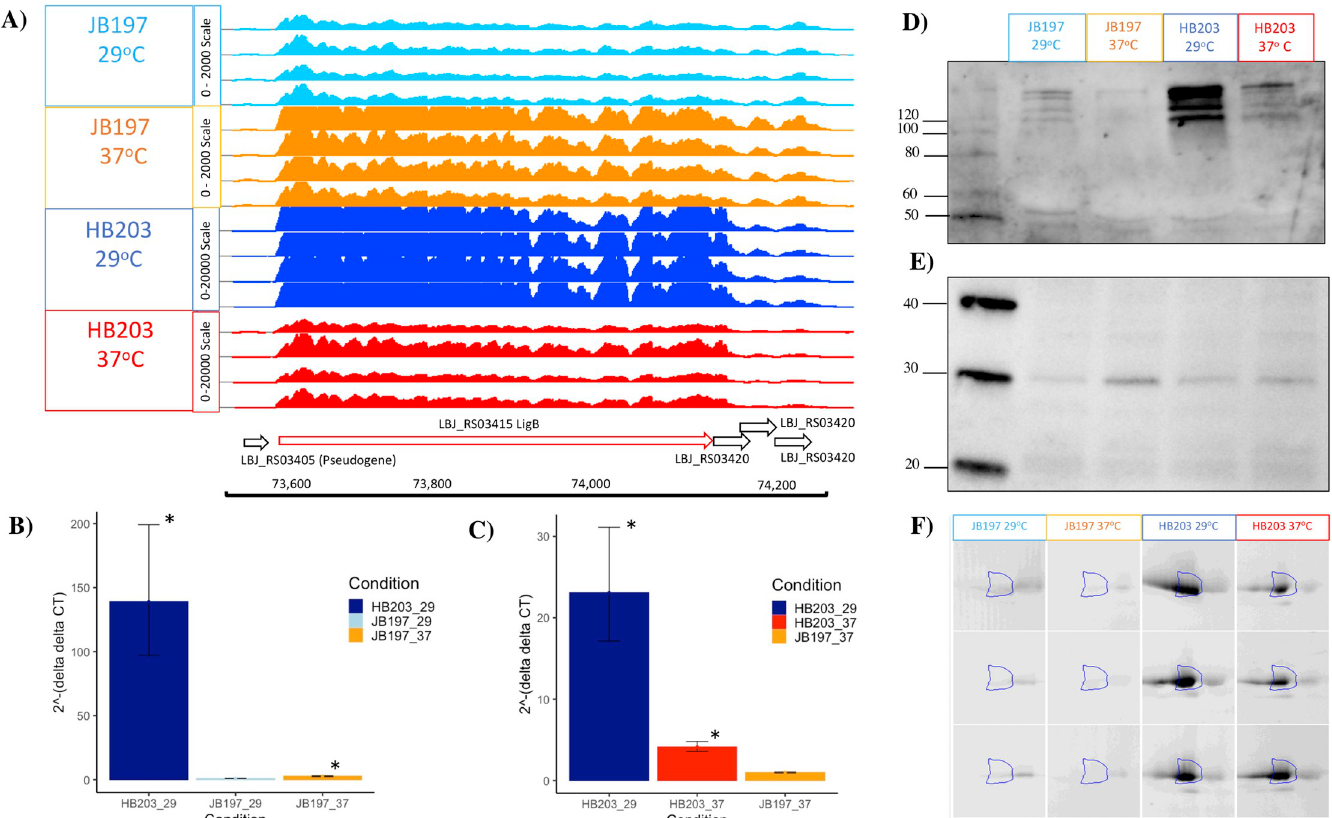
Fig 5. Evaluation of LigB expression in JB197 and HB203. (A) Integrated Genome Browser (IGB) view of gene expression (light blue = JB197 at 29˚C, orange = JB197 at 37˚C, dark blue = HB203 at 29˚C, red = HB203 at 37˚C). Note that Y-axis normalized read count scales are different; JB197 (both temperatures) was scaled to 0–2,000, while HB203 (both temperatures) was scaled 0–20,000. Validation of RNAseq data by RT-qPCR of ligB relative to JB197 at 29˚C, using secA as the control gene for the 29˚C (JB197 vs. HB203) and JB197 (37˚C vs. 29˚C) contrasts (B) or rho as the control gene for the 37˚C (JB197 vs. HB203) and HB203 (37˚C vs. 29˚C) contrasts normalized to the expression of JB197 37˚C (C). Each lane of the immunoblot contains approximately 5 x 10 8 leptospires of L . borgpetersenii serovar Hardjo strain JB197 and HB203 cultured at 29 or 37˚C with (D) anti-LigB and (E) anti-LipL45. (F) DIGE of LigB in strain JB197 and HB203 cultured at 29 or 37˚C. Molecular mass markers (kDa) are indicated. � indicates a p-value < 0.05. Error bars represent 95% confidence